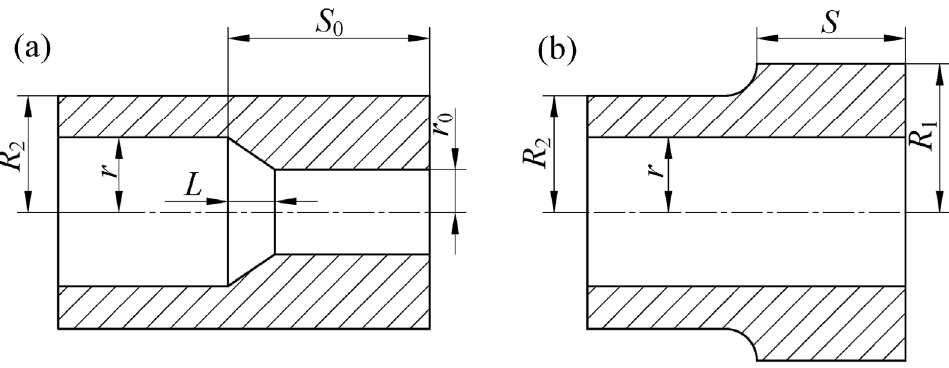
Figure 2. Schematic diagram of preforming design method: ( a ) target forging; ( b ) preform.